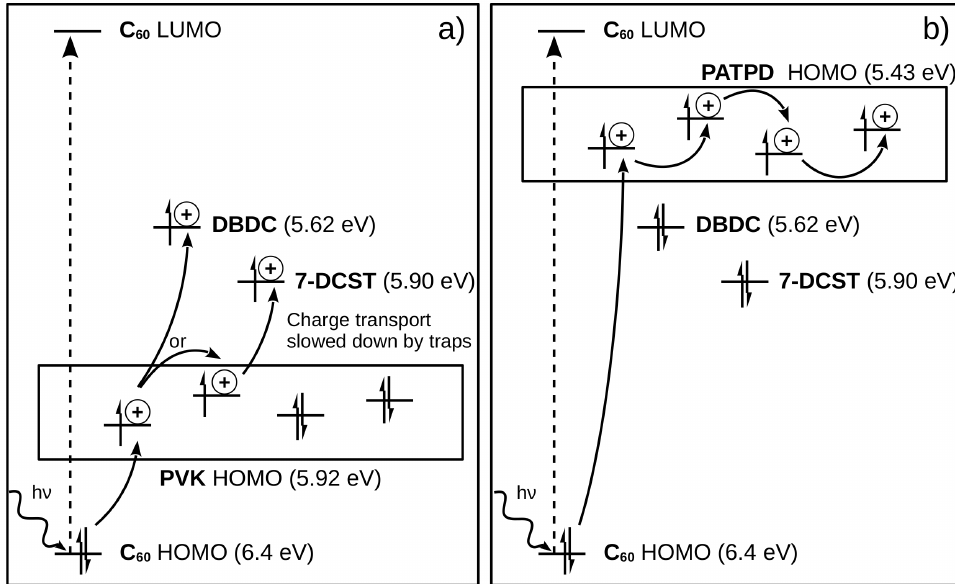
Figure 2. Energy levels of two different photorefractive polymers. ( a ) The chromophores DBDC and 7-DCST can play the role of deep traps for the hole in the PVK polymer matrix, making the PVK photorefractive response slower (>100 ms). ( b ) The PATPD polymer matrix has its HOMO level above the chromophores DBDC and 7-DCST, making it a fast transporting compound (response time <20 ms). Redraw from Reference [44], with